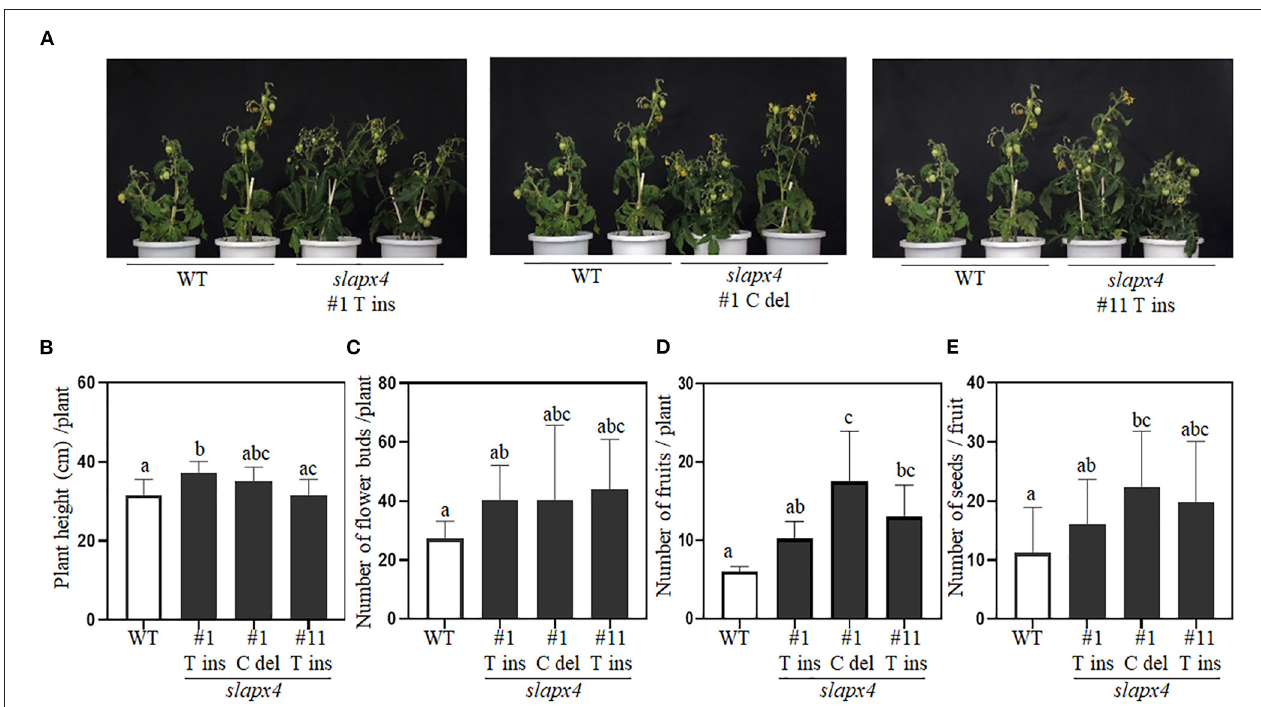
FIGURE 5 | Phenotypic analysis of SLAPX4 mutant plants. (A–E) Wild-type (WT) and SLAPX4 mutant plants ( SLAPX4 #1T ins, #1C del, and #11T ins) were grown on the soil until maturity. (A) The phenotype of the representative plants was visualized by taking a picture at the mature green stage. Same WT plants were used for three independent pictures. Plant height (B) , flower bud number (C) , fruit number (D) , and seed number (E) per plant were measured from ten independent plants. Data represent the mean value + SD ( n = 10). A significant difference was shown with different letters above the bars (one-way ANOVA